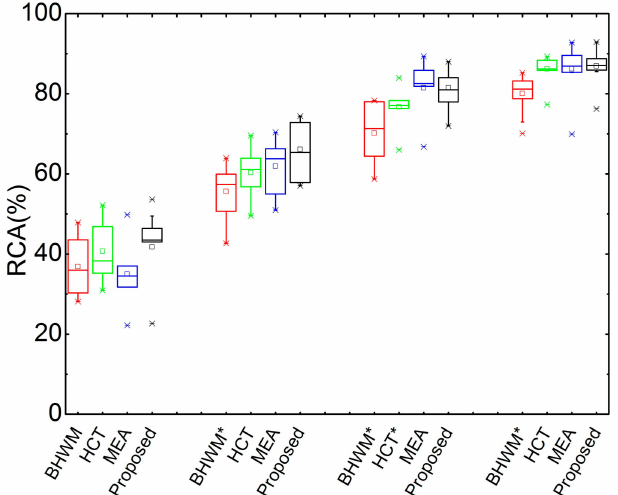
Figure 4. RCAs of compared methods on Bach10